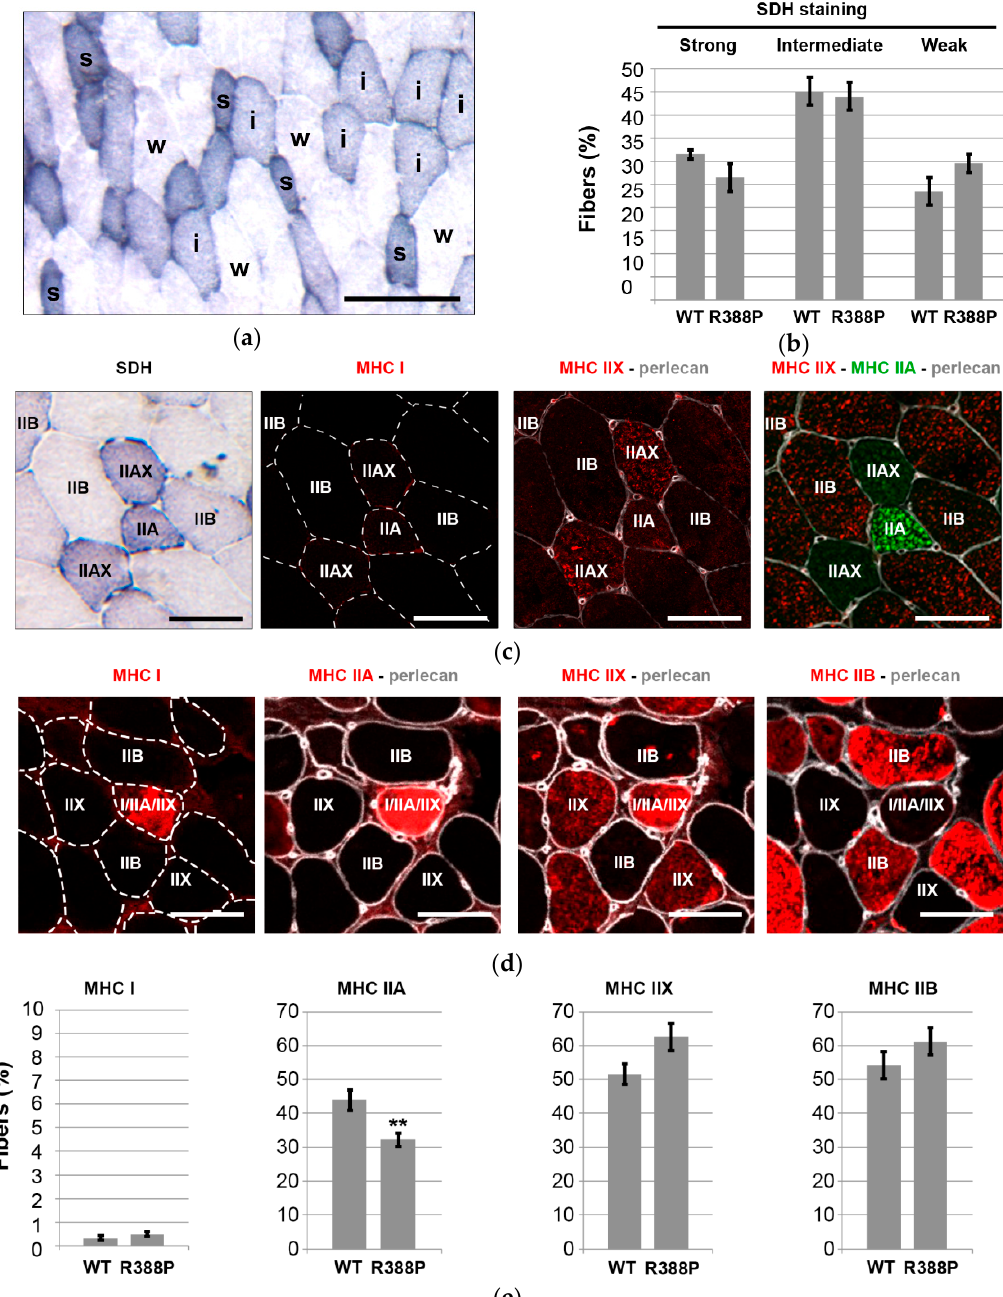
Figure 3. Fiber type distribution analyses in mouse TA muscles expressing AAV-mediated lamin A. ( a ) Representative image show the staining for succinate dehydrogenase (SDH) activity in a transverse sections of TA muscle upon expression of mutant lamin A. Labels of s, i, and w indicating strong, intermediate, and weak SDH staining, respectively. Scale bar represents 100 μ m. ( b ) Mean percentage ± s.e.m of fibers with SDH activity relative to total number of fibers in a muscle section expressing WT or R388P mutant lamin A ( n = 8–11 muscles). ( c , d ) Representative images show the staining in successive transverse sections of TA muscle upon expression of mutant lamin A for SDH and Myosin heavy chain (MHC) isoforms MHC I, MHC IIA, MHC IIX, or MHC IIB. Perlecan staining delimited individual fibers. Scale bars represent 50 μ m. ( e ) Mean percentage ± s.e.m of fibers expressing MHC I, MHC IIA, MHC IIX, or MHC IIB relative to total number of fibers in a muscle section expressing WT or R388P mutant lamin A ( n = 8–11 muscles). ** p < 0.05 (Mann–Whitney test). Frequency of non-oxidative fibers (weak SDH staining) was slightly higher in muscles expressing mutant lamin A compared to WT lamin A (Figure 3b), and these were glycolytic fibers